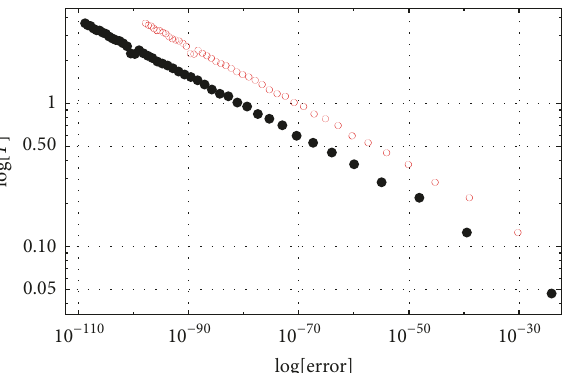
Figure 3: Numerical solution of the chaotic Lorenz system, (32), using the RK4 and IPS methods. Parameters: for IPS (solid black line), 𝑁 = 16 , 𝑁 = 5000 . For RK4 (dashed red line), 𝑁 = 2 × 10 5 . For both curves we used 𝑁 max 𝑏 = −8/3 , and 𝑅 = 28 .